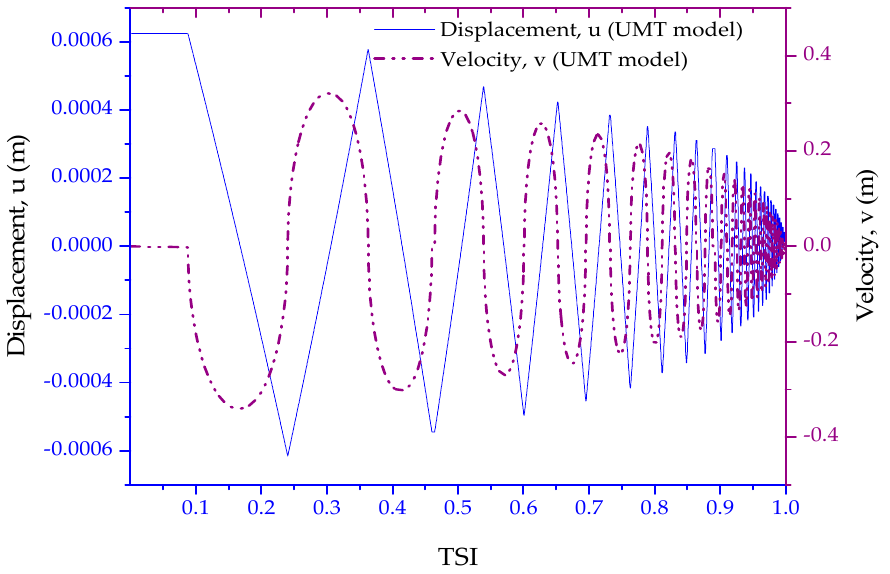
Figure 5. The response of mass-spring oscillator along with the Thermodynamic State Index (TSI) axis.